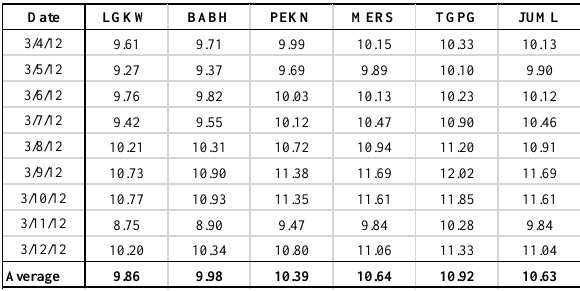
Table 3. Ionospheric delay for all MyRTKnet stations at frequency, L1= 1575.42 MHz. Table 4 is shown the I z on L2 frequency (1227.60 MHz) for all stations. From the table, the average of the I z is between 16.24